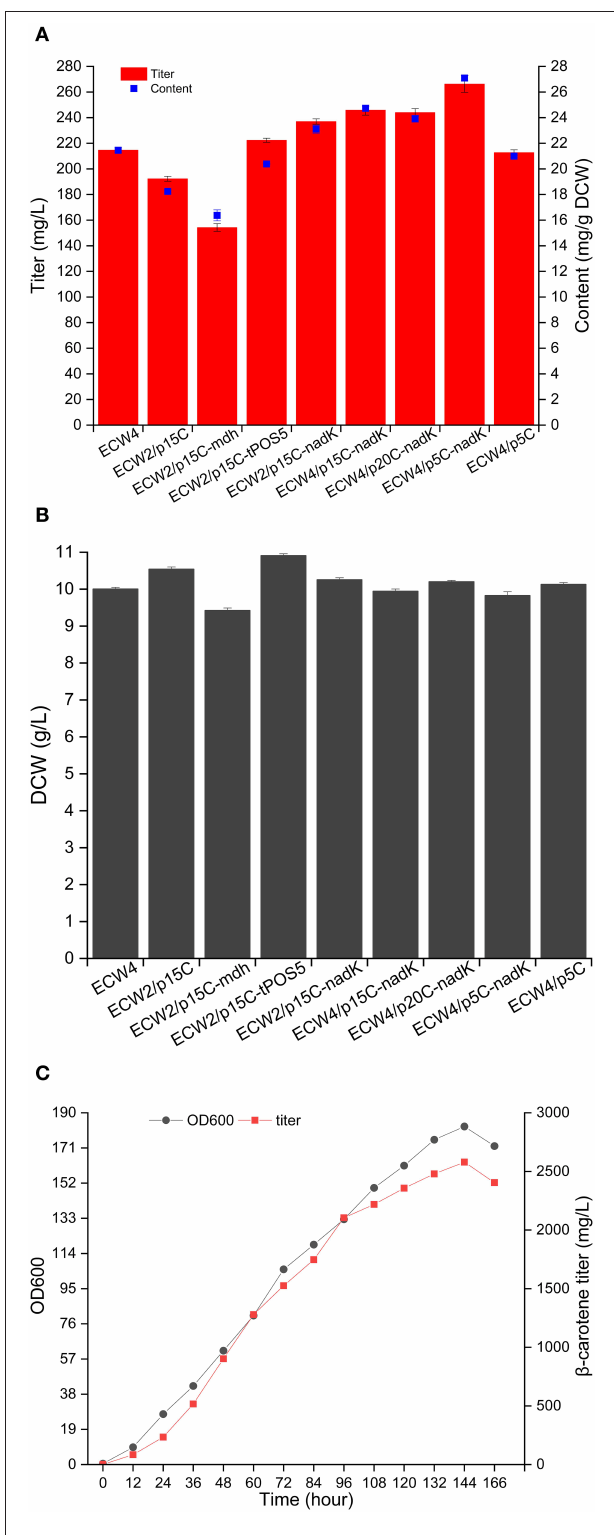
FIGURE 4 | NADPH supply to increase β -carotene production by different engineered Escherichia coli strains. Production of β -carotene (A) and biomass